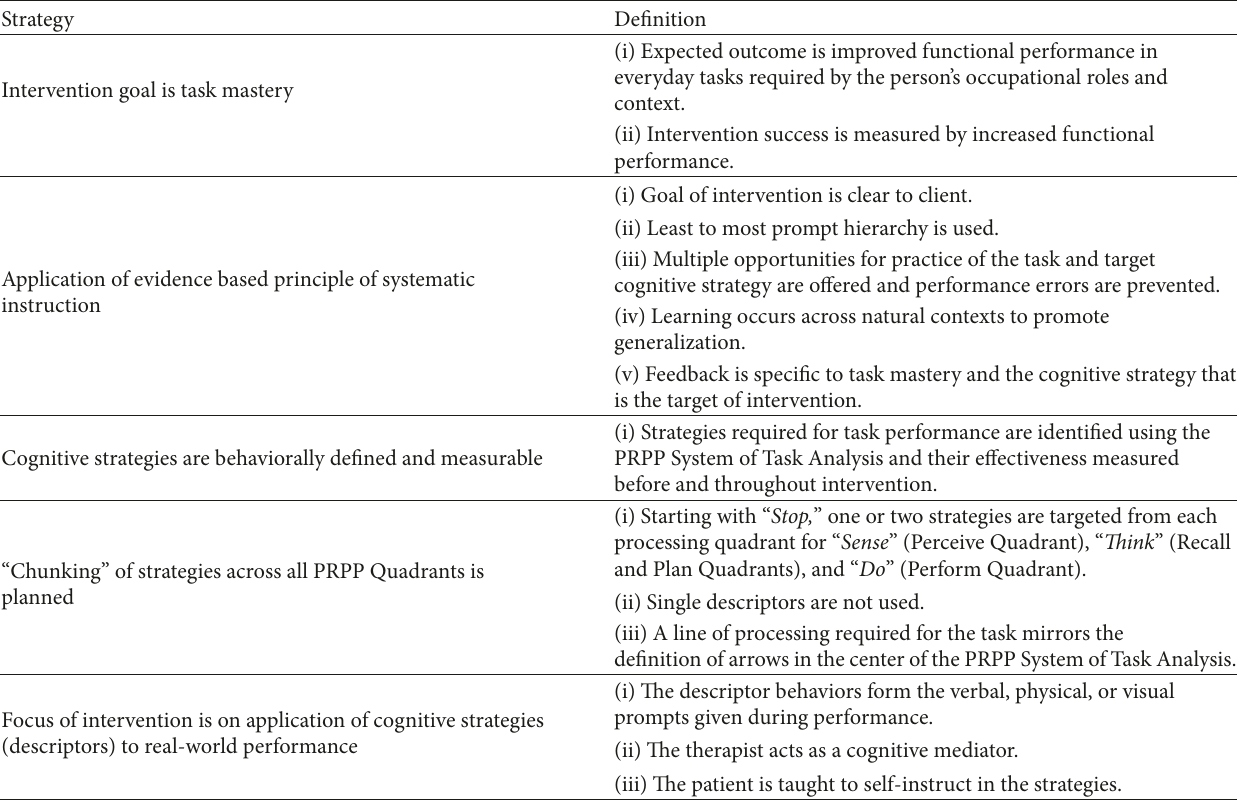
Table 1: PRPP Core Intervention Strategies [8].